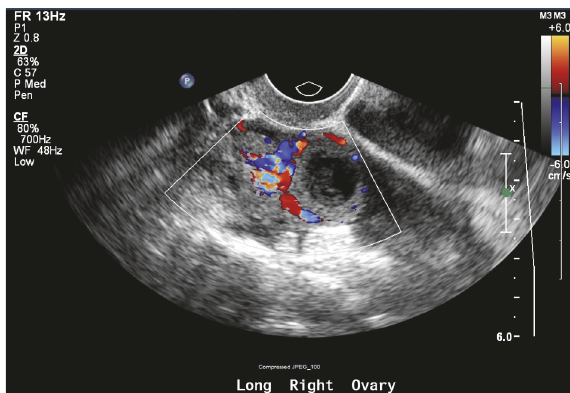
Figure 3: Left tubal ectopicpregnancy (activebleeding, treated with salpingectomy).